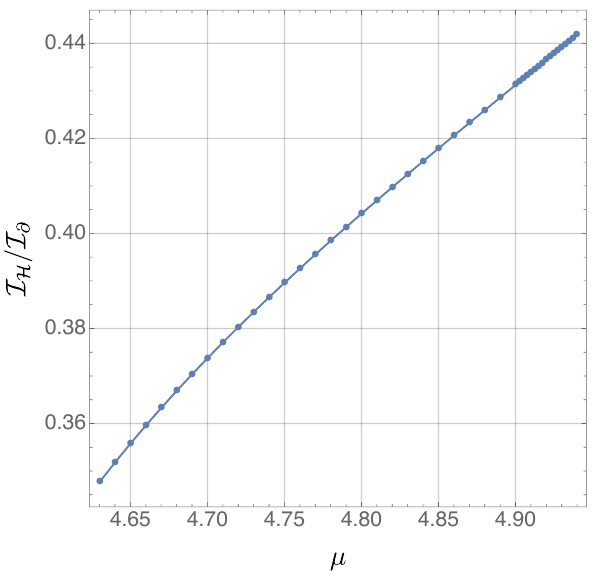
Figure 15 . A comparison of the (regulated) area of the horizon and boundary for the new solutions as a function of (cid:22) for T = 1 = (2 (cid:25) ) and (cid:23) = 1 = 2. The fact that the ratio does not vanish near the boundary with D3 ( (cid:22) (cid:25) 4 : 949) shows the horizon area is increasing at the same rate.